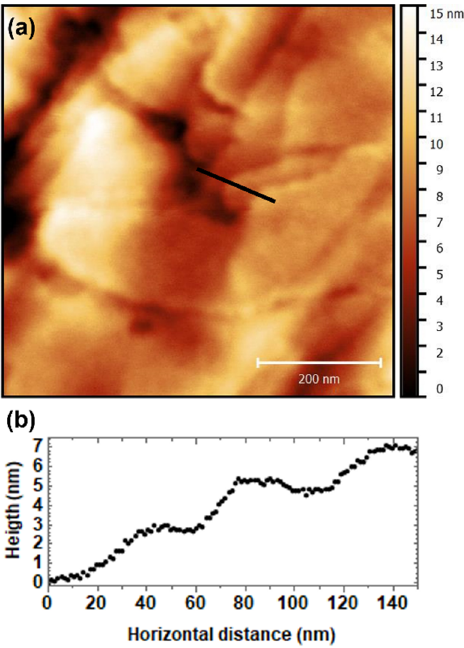
Figure 6. ( a ) AFM topography of DSCG doped with Trans-Hyp; and ( b ) line profile of the terraces on the surface.